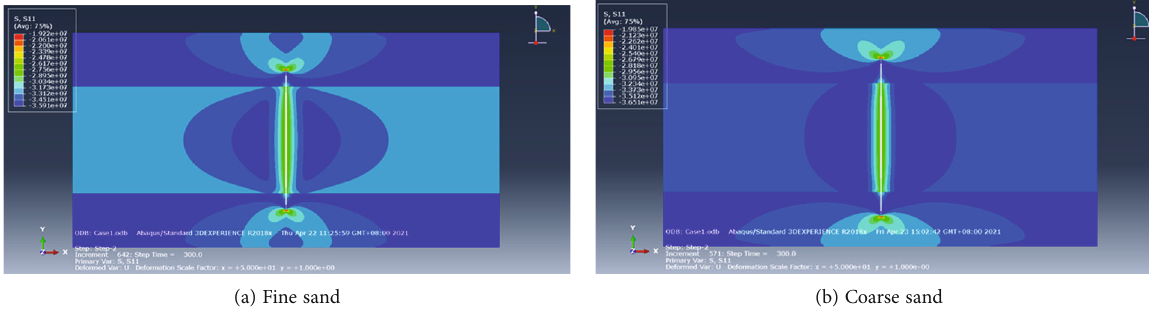
Figure 7: The in fl uence of the rock property on height